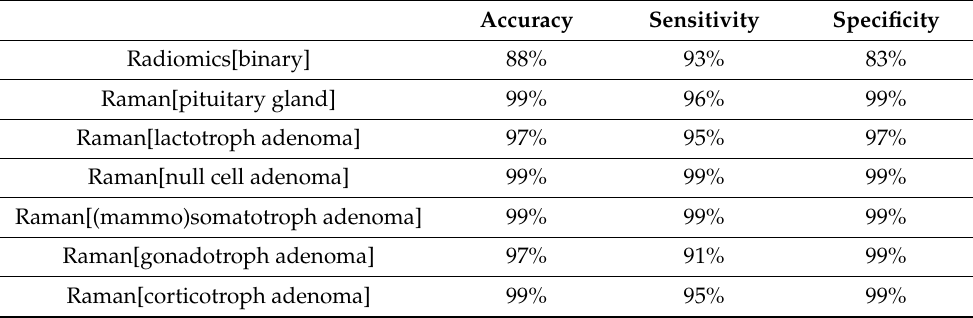
Figure 8. Spider plot for differentiation between pituitary gland and pituitary adenoma subtypes. It combines binary classification by radiomic analysis, TPEF signal analysis and RS. MPM contrast arises from SHG and TPEF signals, revealing information about amount of collagen and collagen distribution as well from differences in the NADH and FAD signals (TPEF NADH vs. FAD), re- spectively. For subclassification into pituitary adenoma subtypes, Raman ratios including collagen, protein, lipid, carotenoid and DNA ratios were identified as relevant. Table 3. Performance of radiomics, and PCA-SVM on Raman spectra. Please note that radiomics performance values are from a 100-fold Monte Carlo cross-validation, while PCA-SVM performance values demonstrate the discrimination power of Raman